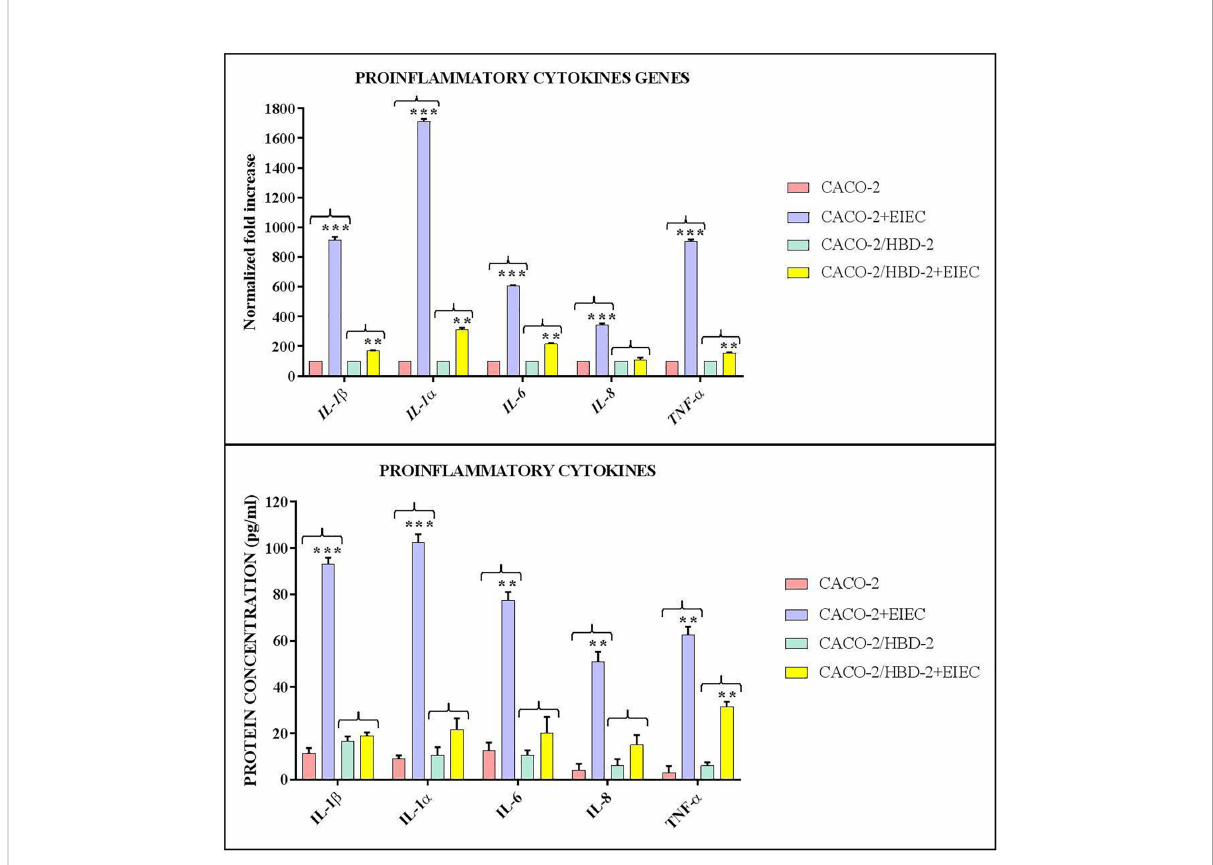
FIGURE 4 Real-Time PCR results show the effects of HBD-2 on expression of invasion-associated genes in EIEC incubated for 3 hours with Caco-2/HBD- 2 and Caco-2 cells, shown as relative gene expression. Data are representative of three different experiments ± SD. Signi fi cant differences are indicated by **p<0.01,